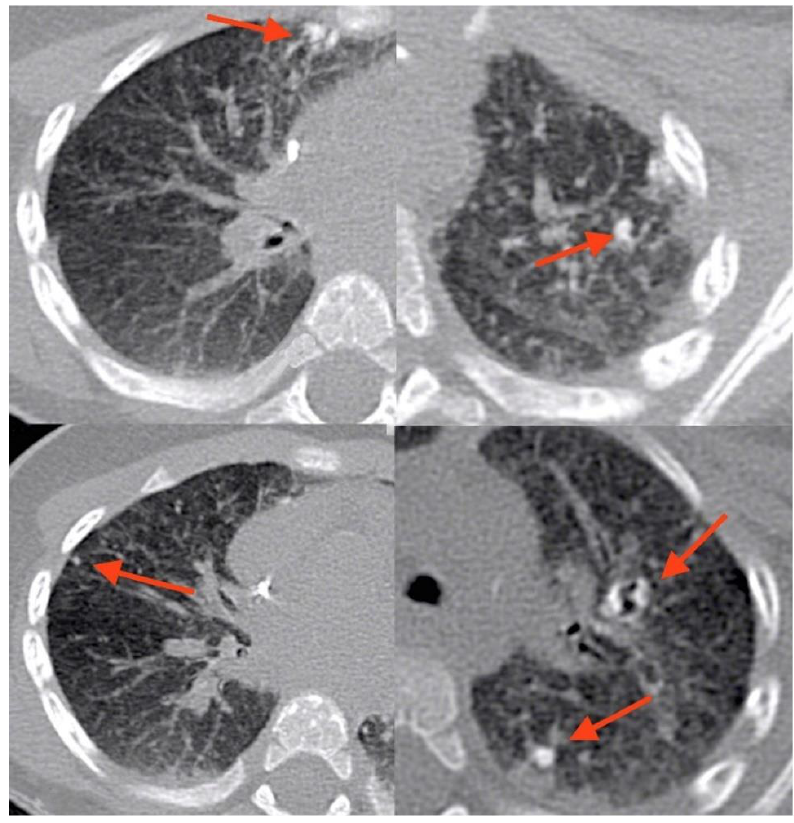
Figure 2. CT scan showing multiple parenchymal calcifications (indicated with arrows).